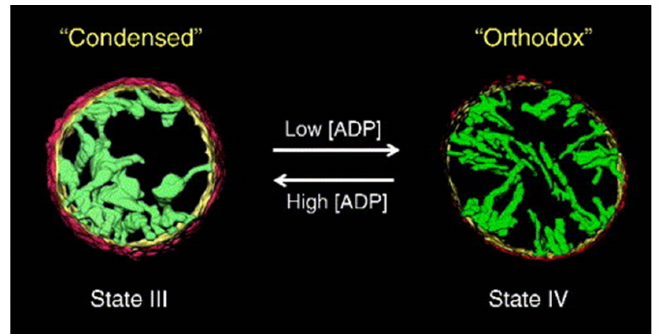
Figure 3. Illustration of the cross section of a mitochondrion observed under different metabolic conditions. The condensed morphology appears in the presence of high ADP concentrations, when mitochondria are producing ATP (state III), while the orthodox configuration occurs at low ADP concentrations, with no production of ATP (state IV). Reproduced with permission from Manella [25], Biochim. Biophys. Acta; published by Elsevier,